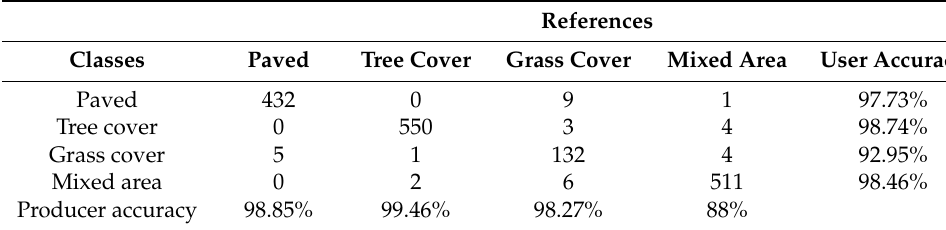
Table A1. Confusion matrix of the land use land cover classification.